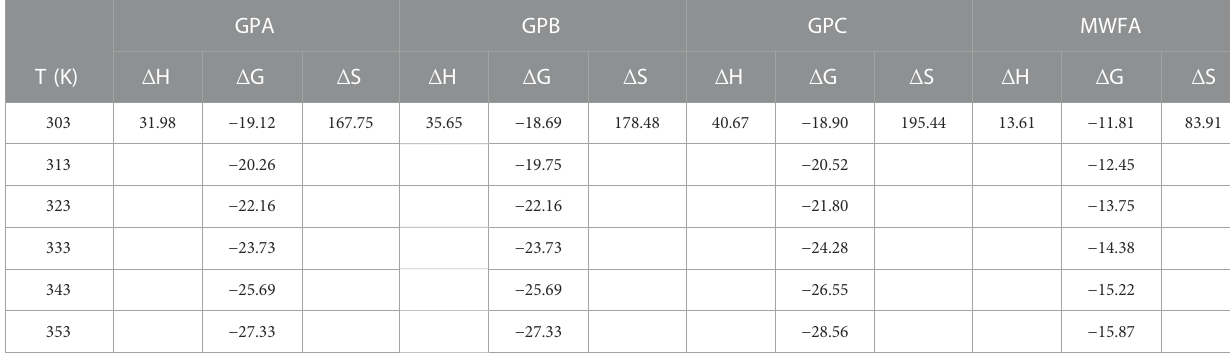
TABLE 3 Obtained thermodynamic parameters of GPA, GPB, GPC, and